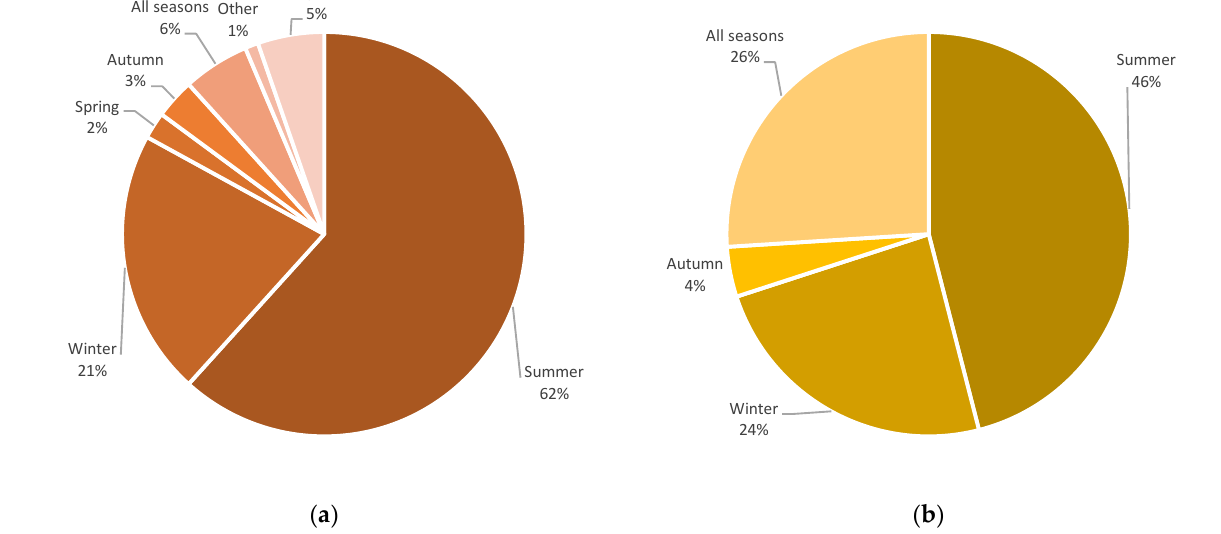
Figure 13. ( a ) The studied seasons for thermal performance; ( b ) the studied seasons for electricity energy performance.